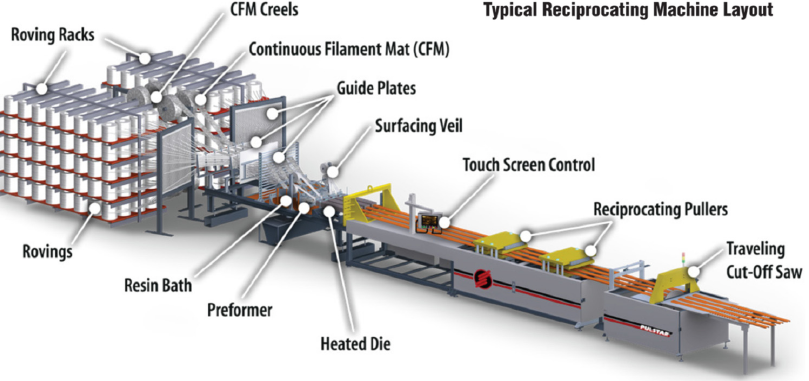
Figure 7. Schematic diagram of pultrusion process (Courtesy of Strongwell [12]).